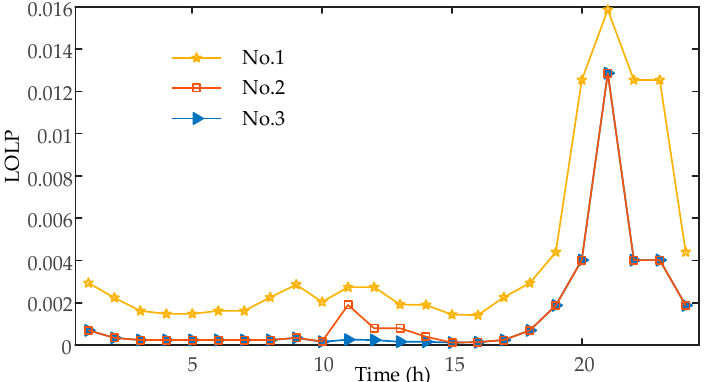
Figure 7. Curves of risk indicator loss of load probability (LOLP).